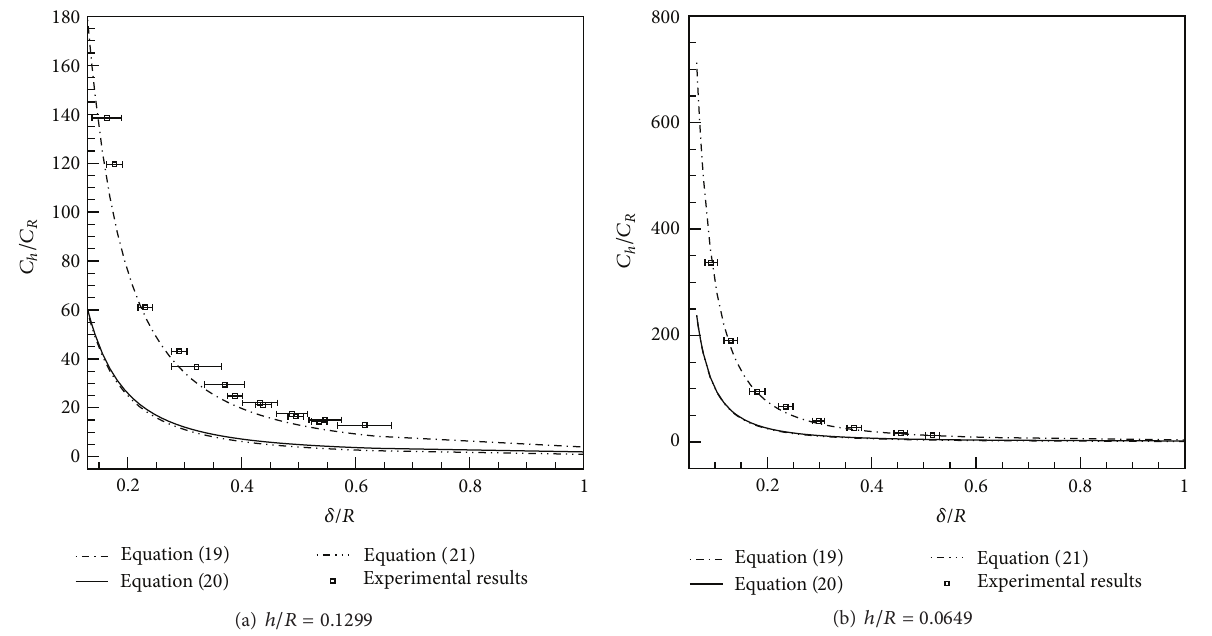
Figure 5: Comparison of the dimensionless experimental results and (19)–(21) regarding hydraulic capacitance in the nonlinear region: (a) plotted as ℎ/𝑅 = 0.1299 ; (b) plotted as ℎ/𝑅 = 0.0649